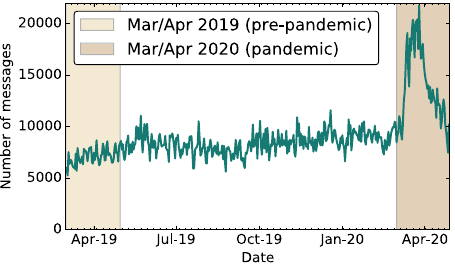
Fig. 2 Number of messages per day. The fi gure shows the total number of messages for each day from the beginning of March 2019 until the end of April 2020. On the left-hand side the background is colored for the Mar/ Apr 2019 pre-pandemic period, on the right-hand side the lockdown period in Mar/Apr 2020 is